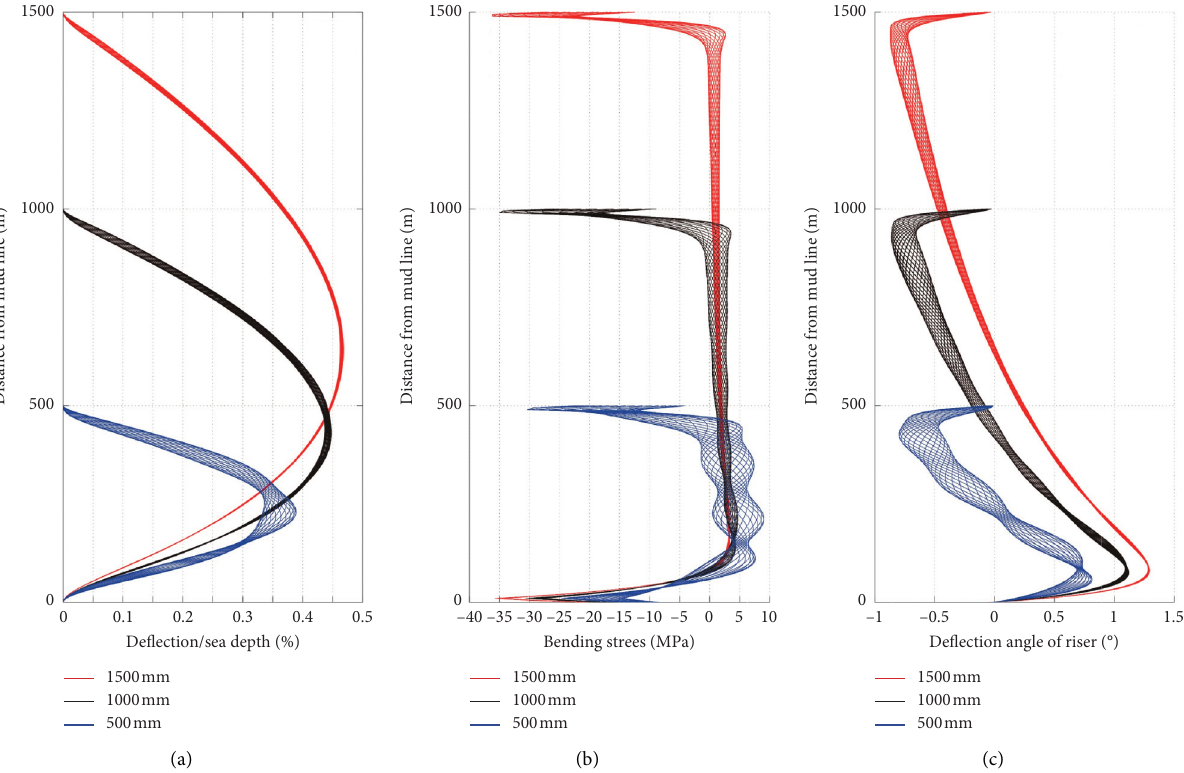
Figure 6: Comparison of dynamic responses for risers with different lengths, (a) distribution of lateral deflection, (b) distribution of bending stress, and (c) distribution of deflection angle of the